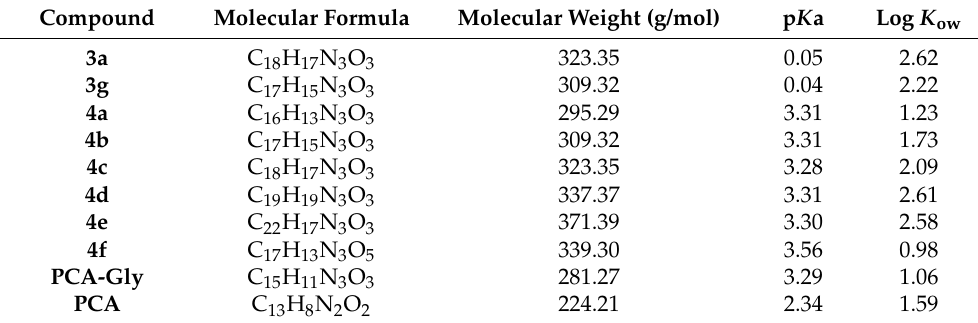
Table 2. Physicochemical properties of compounds 3a , 3g , 4a–4f , PCA-Gly, and PCA.